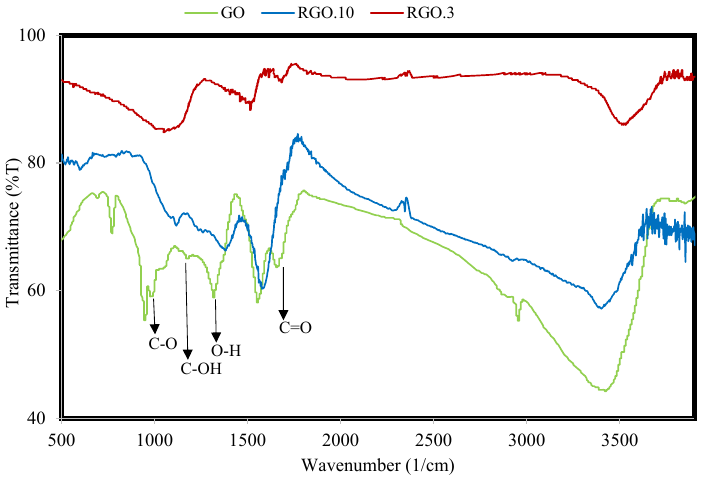
Fig. 3. The FT-IR spectra of GO, RGO.3, and RGO.10